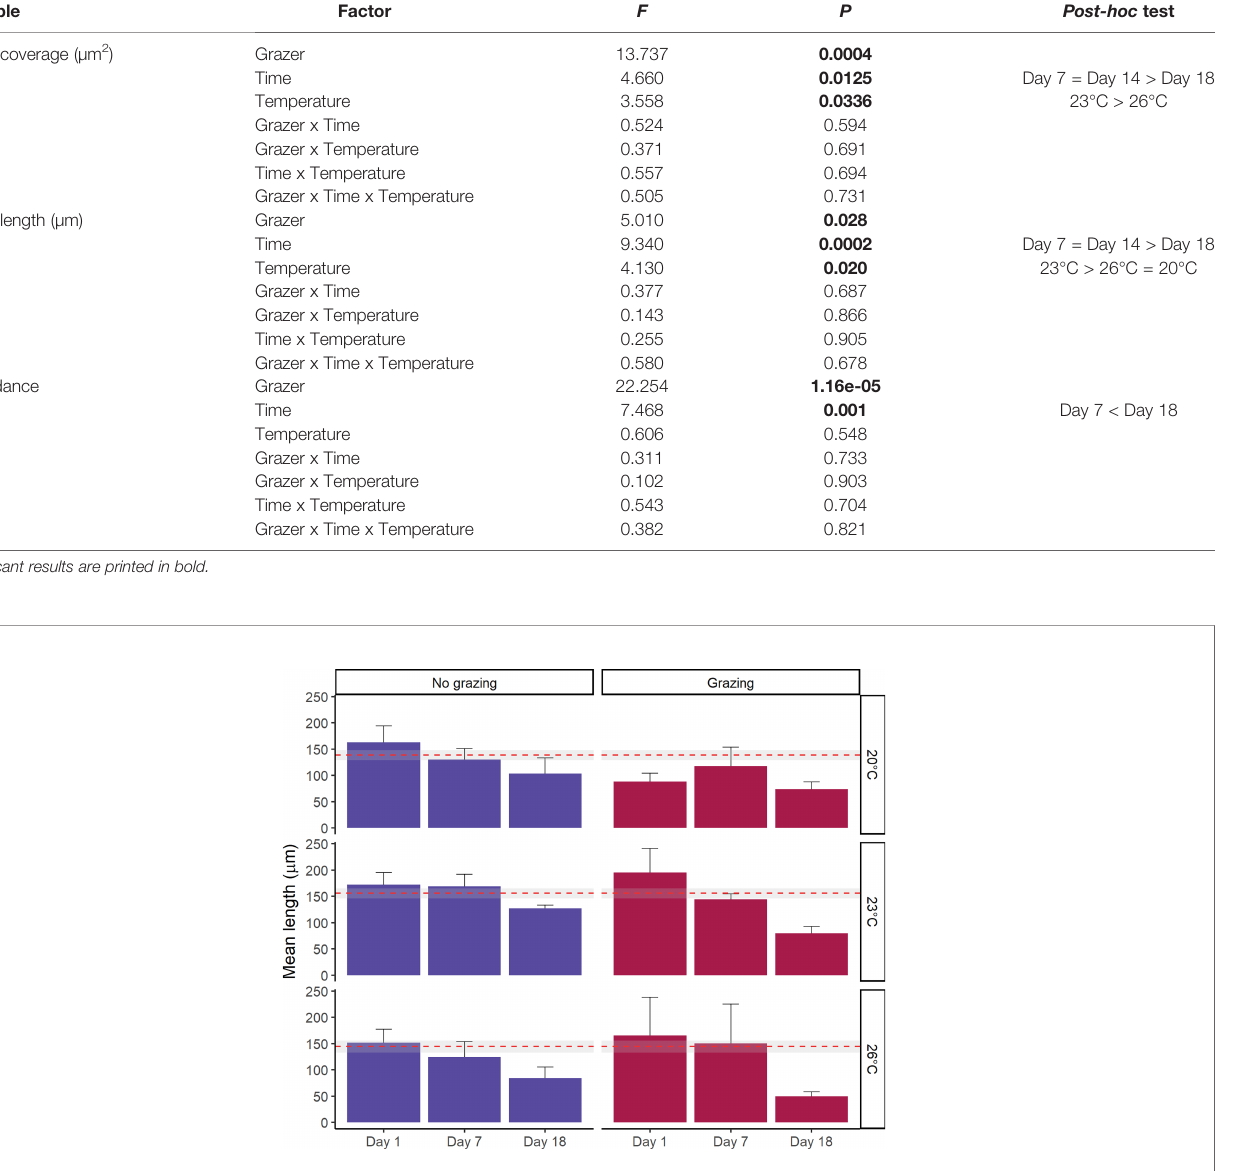
TABLE 1 | Summary table of 3-factor ANOVA of total mean coverage of gametophytes (µm 2 ), mean length (µm) and abundance with grazing, time, and temperature as fi xed factors. Variable